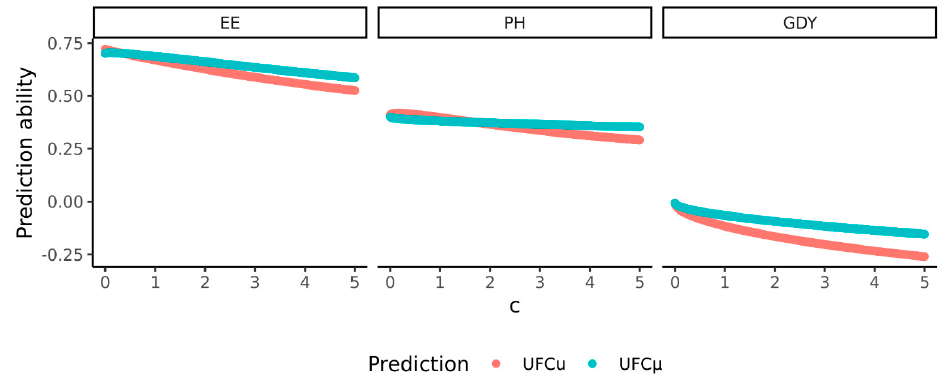
Figure 5. Prediction ability for the UFC varies depending on the complexity of the trait (ear emergence (EE), plant height (PH), and grain yield (GDY)), and the product of the square root of heritability and selection intensity given as the constant c . Two methods of predicting the UFC were applied: UFCu (red) and UFCµ (blue).